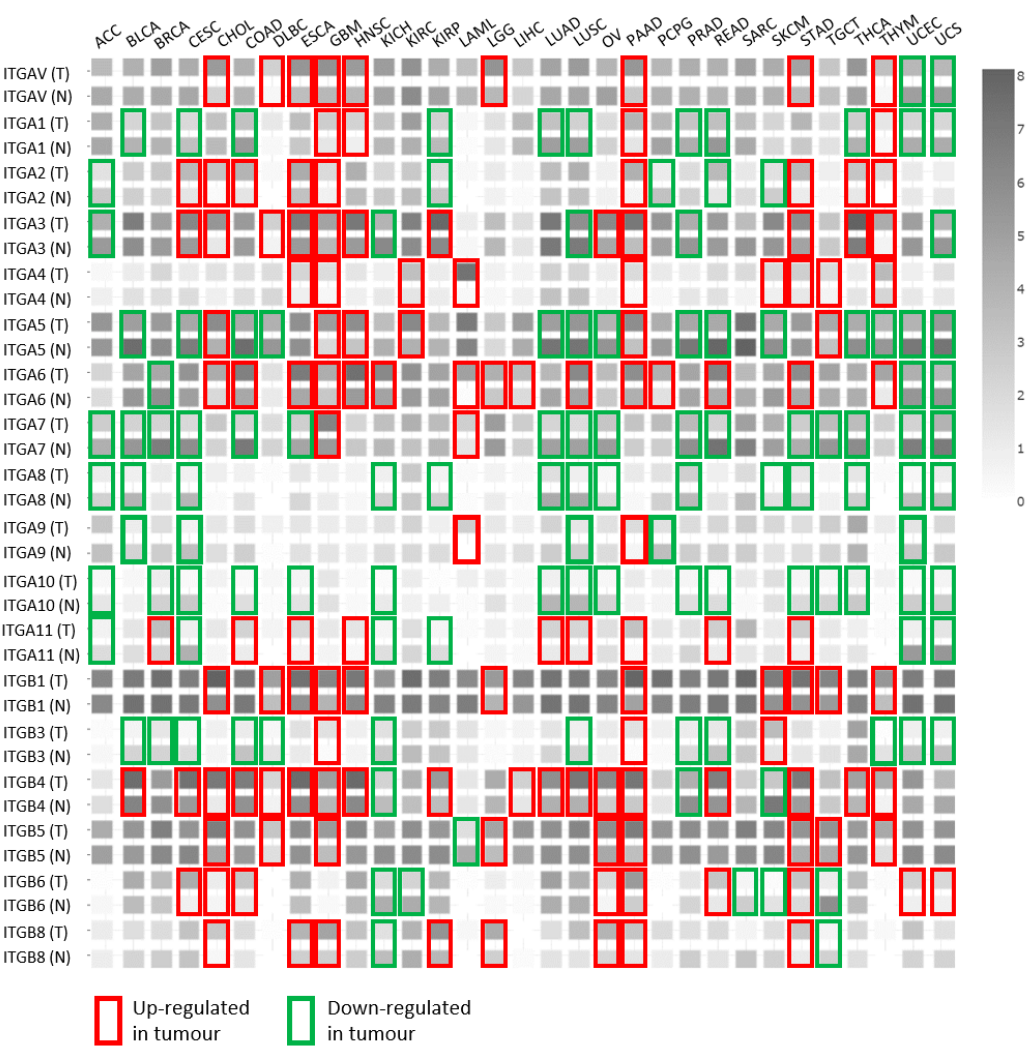
Figure 2. Integrin expression in di ff erent tumor (T) and corresponding normal (N) tissues. Statistically significant changes are marked with a rectangle (log2 fold change > 1, p -value < 0.01). Figure is made using GEPIA software (http://gepia.cancer-pku.cn/) [58]. Abbreviations and number (in parenthesis) of tumor and normal samples analysed (combined TCGA and GTEx), respectively. Tumors are listed in an alphabetical order: ACC, adrenocortical carcinoma (77, 128); BLCA, bladder urothelial carcinoma (404, 28); BRCA, breast invasive carcinoma (1085, 291); CESC, cervical squamous cell carcinoma and endocervical adenocarcinoma (306, 13); CHOL, cholangiocarcinoma (36, 9); COAD, colon adenocarcinoma (275, 349); DLBC, diffuse large B-cell lymphoma (47, 337); ESCA, esophageal carcinoma (182, 286); GBM, glioblastoma multiforme (163, 207); HNSC, head and neck squamous cell carcinoma (519, 44); KICH, kidney chromophobe (66, 53); KIRC, kidney renal clear cell carcinoma (523, 100); KIRP, kidney renal papillary cell carcinoma (286, 60); LAML, acute myeloid leukemia (173, 70); LGG, lower grade glioma (518, 207); LIHC, liver hepatocellular carcinoma (369, 160); LUAD, lung adenocarcinoma (483, 347); LUSC, lung squamous cell carcinoma (486, 338); OV, ovarian serous cystadenocarcinoma (426, 88); PAAD, pancreatic adenocarcinoma (179, 171); PCPG, pheochromocytoma and paraganglioma (182, 3); PRAD, prostate adenocarcinoma (492, 152); READ, rectum adenocarcinoma (92, 318); SARC, sarcoma (262, 2); SKCM, skin cutaneous melanoma (461, 558); STAD, stomach adenocarcinoma (408, 211); TGCT, testicular germ cell tumors (137, 165); THCA, thyroid carcinoma (512, 337); THYM thymoma (118, 339); UCEC, uterine corpus endometrial carcinoma (174, 91); UCS, uterine carcinosarcoma (57,